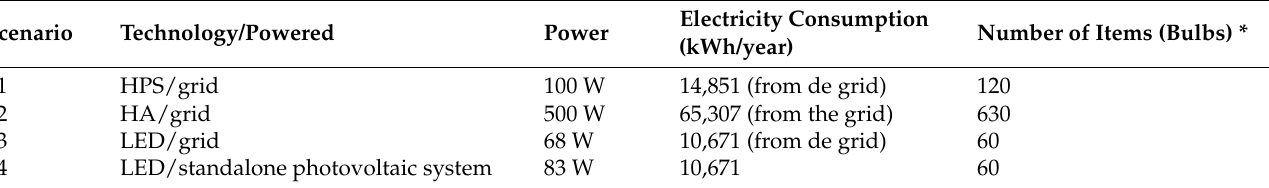
Table 5. Lighting inputs for each scenario and functional unit.